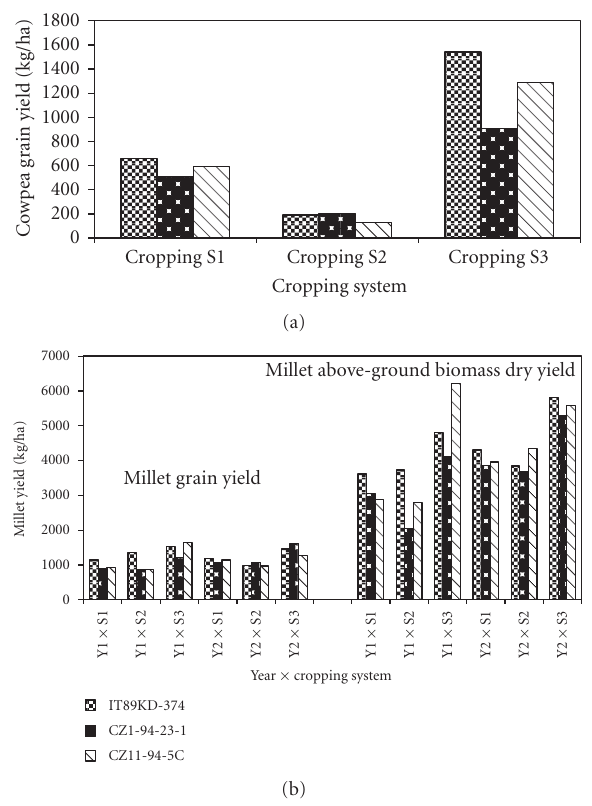
Figure 4: Crops yields: (a) cowpea grain as a ff ected by cropping system × cowpea variety interactions e ff ects ( P < 0 . 01), 2007 and 2008; (b) subsequent millet grain and above-gorund biomass dry yields as a ff ected by year × cropping system × cowpea variety three- way interaction e ff ects at Cinzana Agronomic Research Station, 2008 and 2009. Y1: year 1 (2008), Y2: year 2 (2009), S1: alternate rows intercropping (1 row millet/1 row cowpea), S2: interhills intercropping (2 hills millet/1 hill cowpea), S3: cowpea sole crop, cowpea varieties: IT89KD-374, CZ1-94-23-1, and